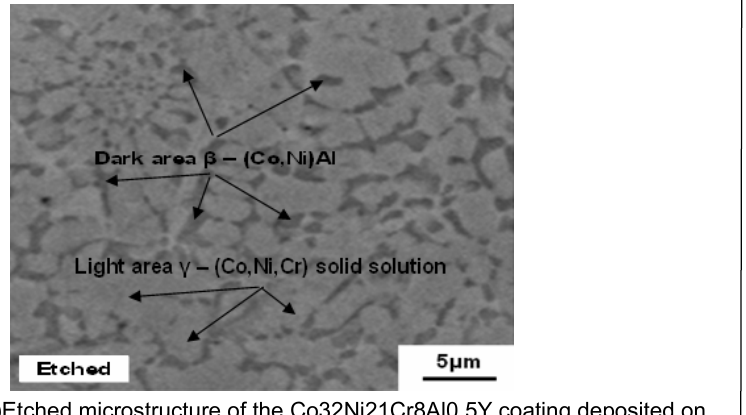
Figure 10 – (SEM)Etched microstructure of the Co32Ni21Cr8Al0.5Y coating deposited on the sample with a substrate distance of 270 mm Slika 10 – (SEM) Nagrizena mikrostruktura Co32Ni21Cr8Al0.5Y prvlake deponovane na uzorku sa odstojanjem substrata 270